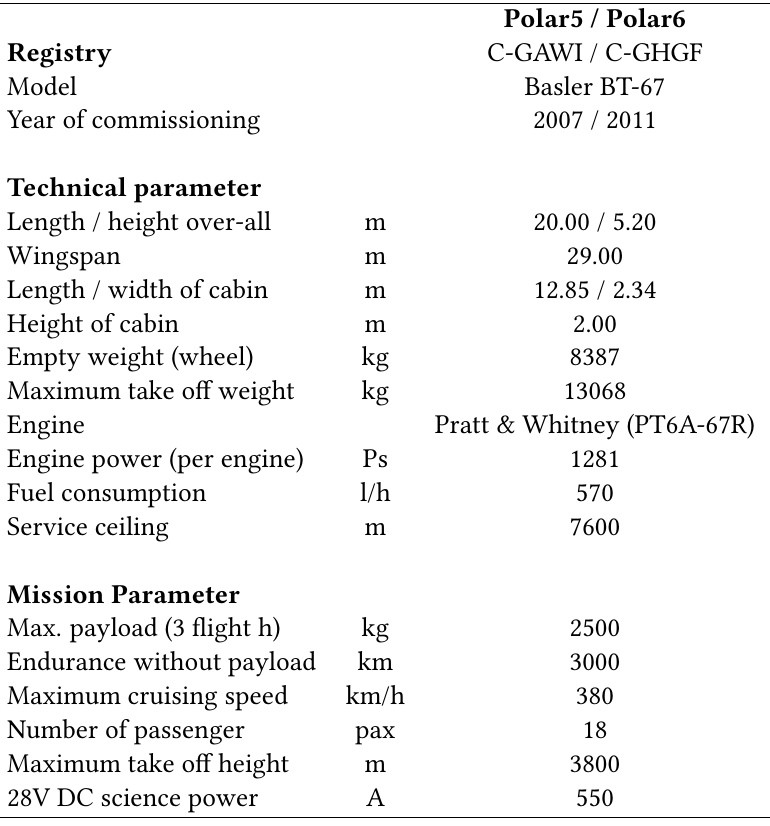
Table 1: Facts about the research aircraft Polar5 and